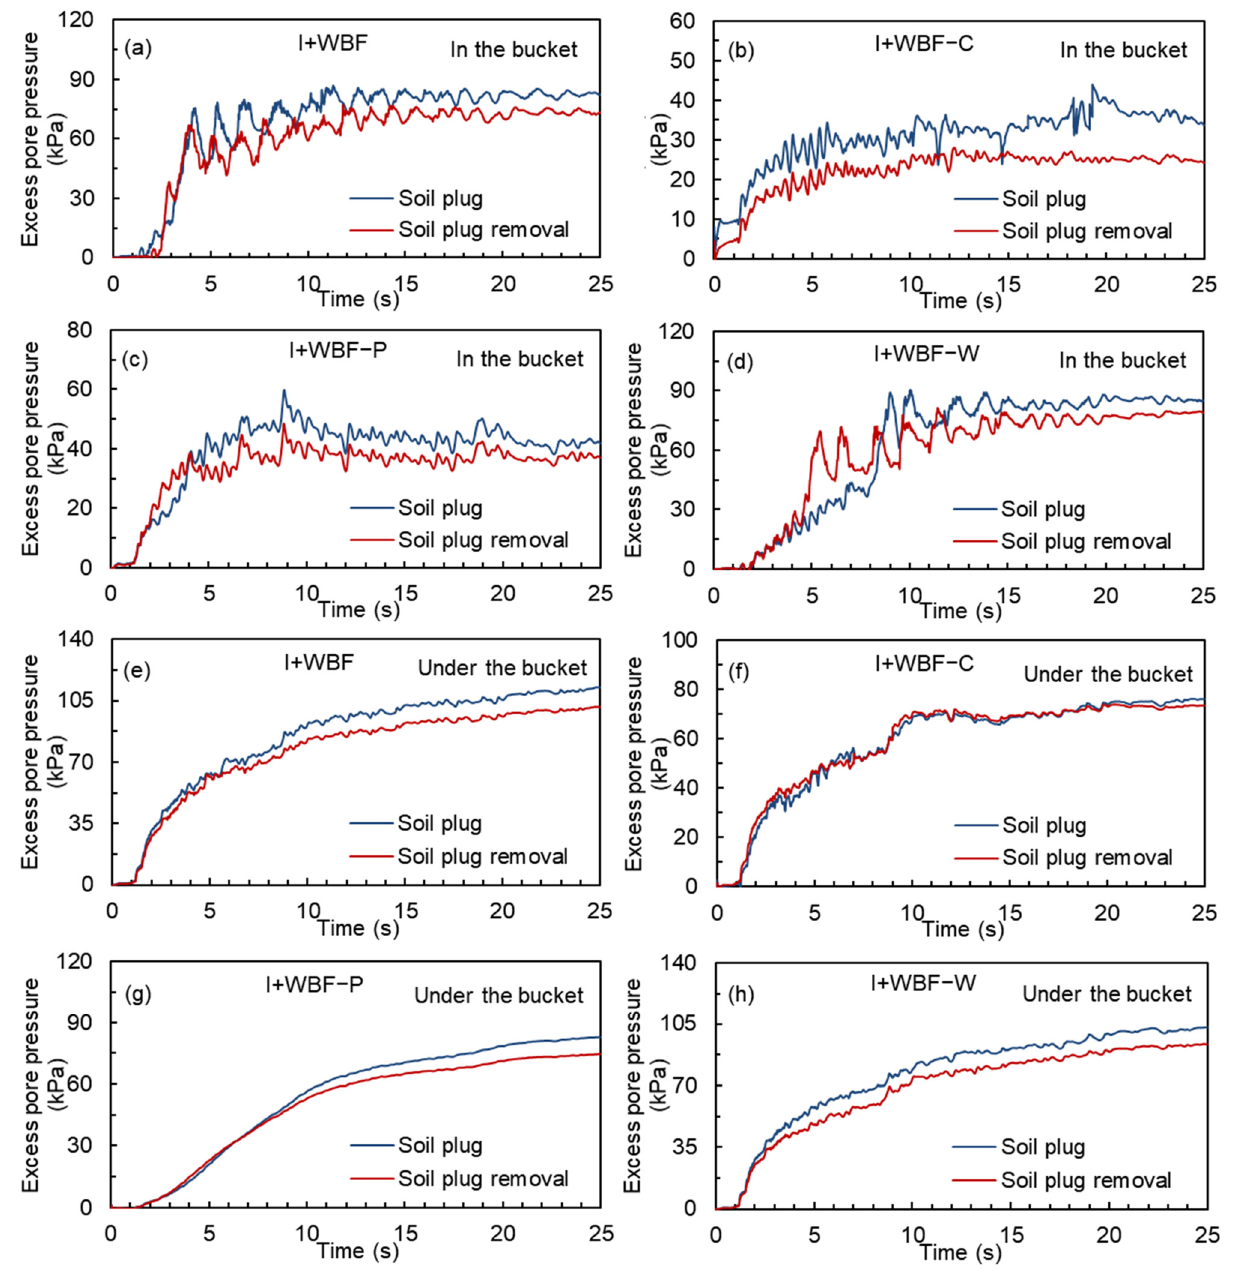
Figure 18. Excess pore pressure time histories of seabed soil for simulations with soil plug and soil plug removal in inclined seabeds: the seabed soil in the bucket ( a ) WBF; ( b ) WBF-C; ( c ) WBF-P; ( d ) WBF-W; the seabed soil under the bucket: ( e ) WBF; ( f ) WBF-C; ( g ) WBF-P; ( h ) WBF-W. The bucket horizontal displacement time histories of unreinforced and reinforced The maximum horizontal displacement and rotation for all computed cases in bucket foundations with soil plug and soil plug removal in inclined seabeds are compared in Figure 19. For unreinforced bucket foundations (DBF or WBF), the horizontal displace- ment response of the bucket foundation was reduced by removing the soil plug. For the deep bucket foundation, soil plug removal had the greatest influence on the horizontal displacement of DBF-P, while for the wide bucket foundation, soil plug removal had the greatest effect on the horizontal displacement of WBF-W.